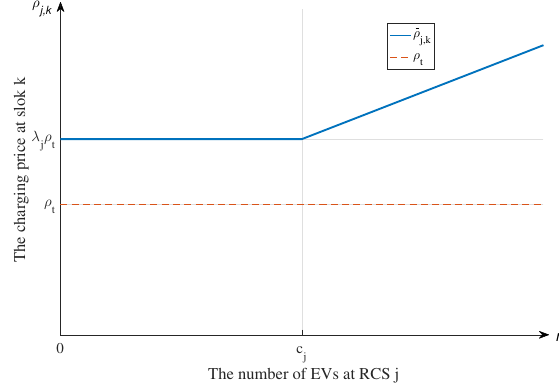
Figure 4. The rapid charging price adjustment